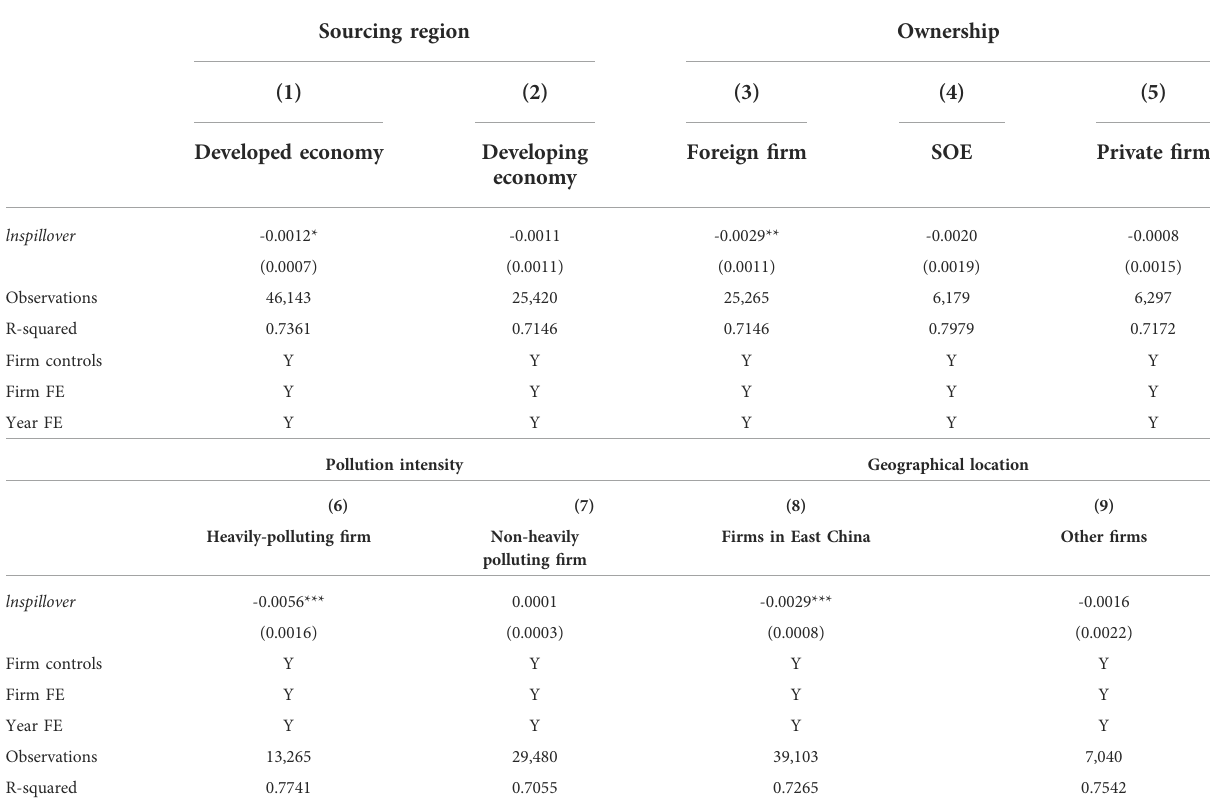
TABLE 5 Heterogenous